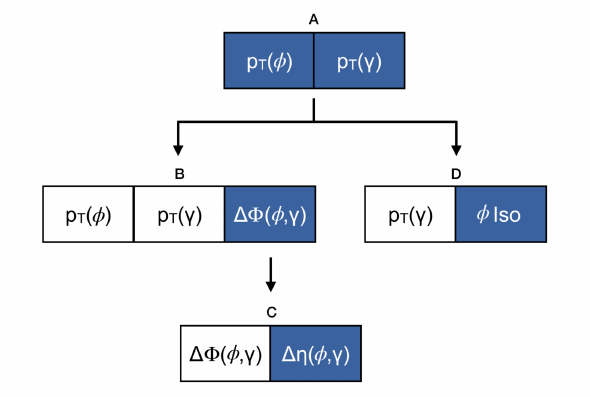
Figure 1 . Graphical representation of the sampling sequence followed in the modelling. Variables not shown explicitly are sampled in a factorised, uncorrelated, manner from an 1D template, as described in table